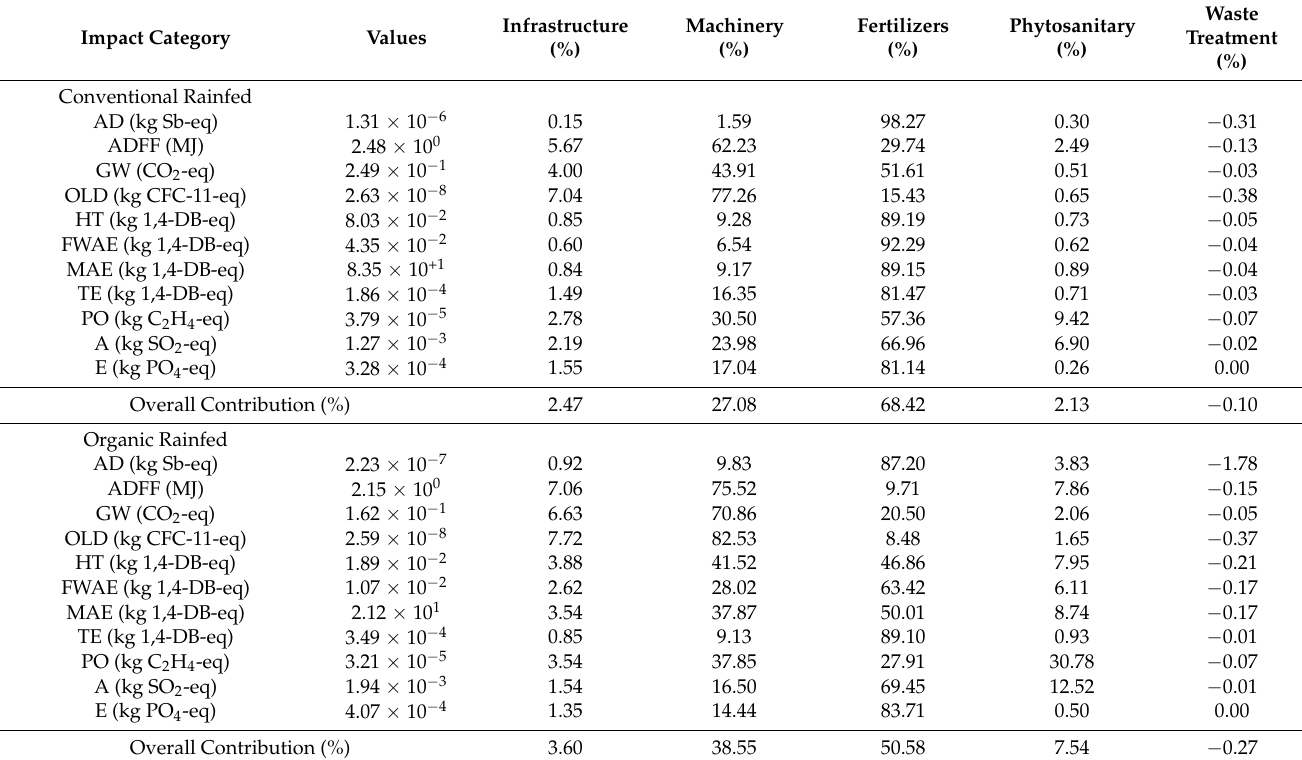
Table 8. Characterization of the potential environmental impacts and contributions of the components of the system in the conventional and organic rainfed